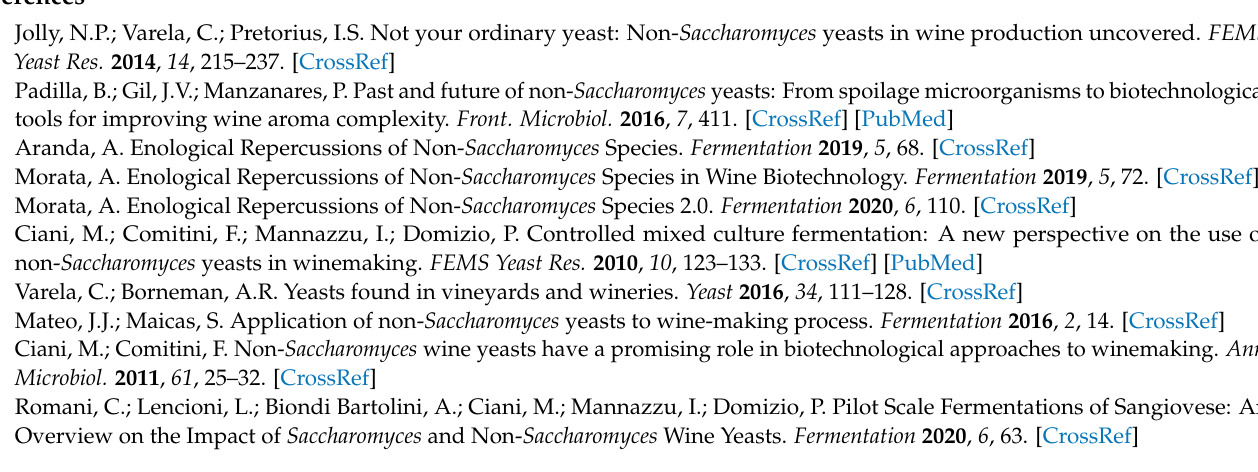
Table S2: Main chemical-physical data of Grillo